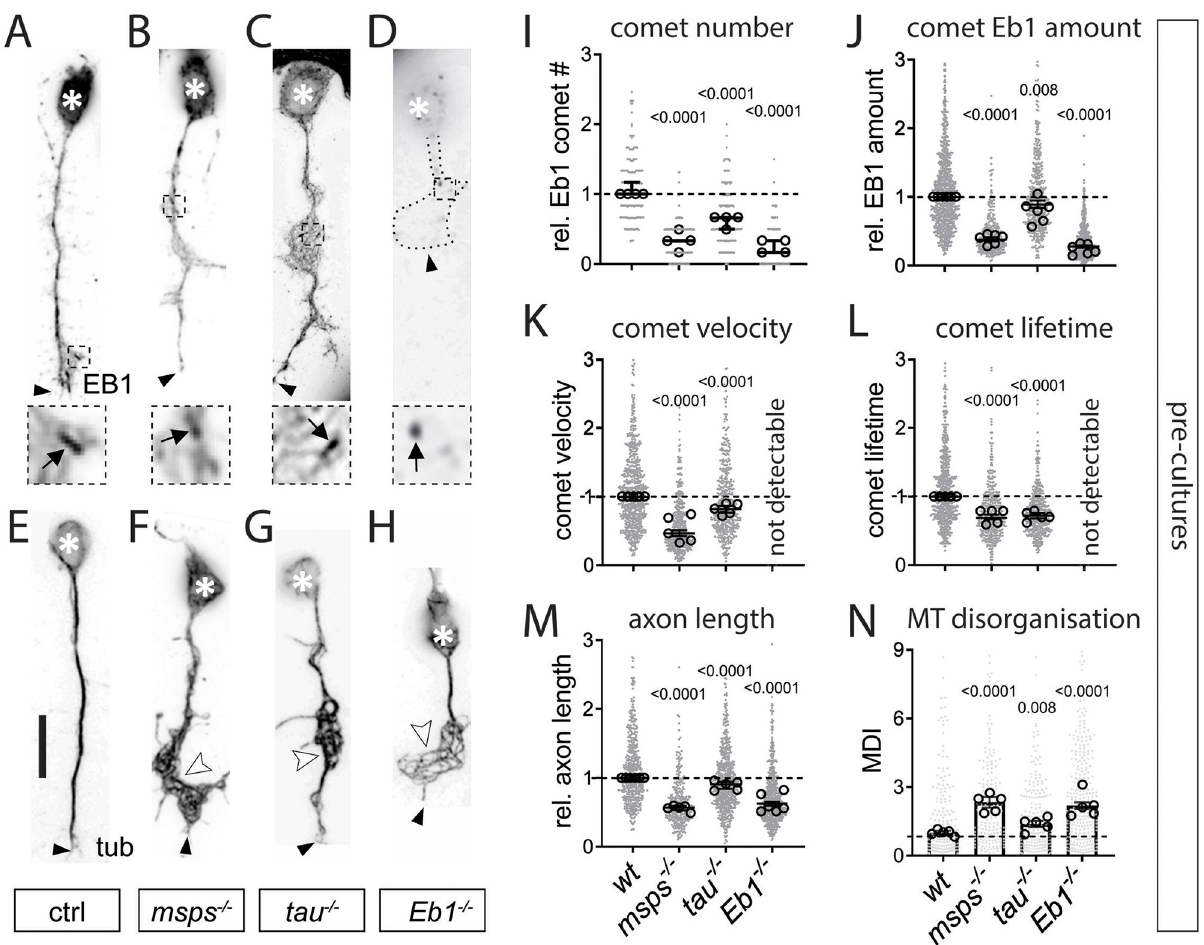
Fig 1. Eb1, Msps and Tau share the same combination of axonal loss-of-function phenotypes in Drosophila primary neurons. A-H ) Images of representative examples of embryonic primary neurons pre-cultured up to 6 days (to deplete maternal gene product; see Drosophila Primary Cell Culture Preparation) and either immuno-stained for Eb1 (top) or for tubulin (bottom); neurons were either wild-type controls (ctrl) or carried the mutant alleles msps 1 , tau KO or Eb1 04524 in homozygosis (from left to right); asterisks indicate cell bodies, black arrow heads the axon tips, white arrow heads point at areas of MT curling, dashed squares in A-D are shown as 3.5-fold magnified close-ups below each image with black arrows pointing at Eb1 comets; the axonal outline in D is indicated by a dotted line; scale bar in A represents 15 μ m in all images. I-N) Quantification of different parameters (as indicated above each graph) obtained from pre-cultured embryonic primary neurons with the same genotypes as shown in A-H. Data were normalised to parallel controls (dashed horizontal line) and are shown as median ± 95% confidence interval (I-M) or mean ± SEM (N); data points in each plot, taken from at least two experimental repeats consisting of 3 replicates each; large open circles in graphs indicate median/mean of independent biological repeats. P-values obtained with Kruskall-Wallis ANOVA test for the different genotypes are indicated in each graph. For raw data see S1